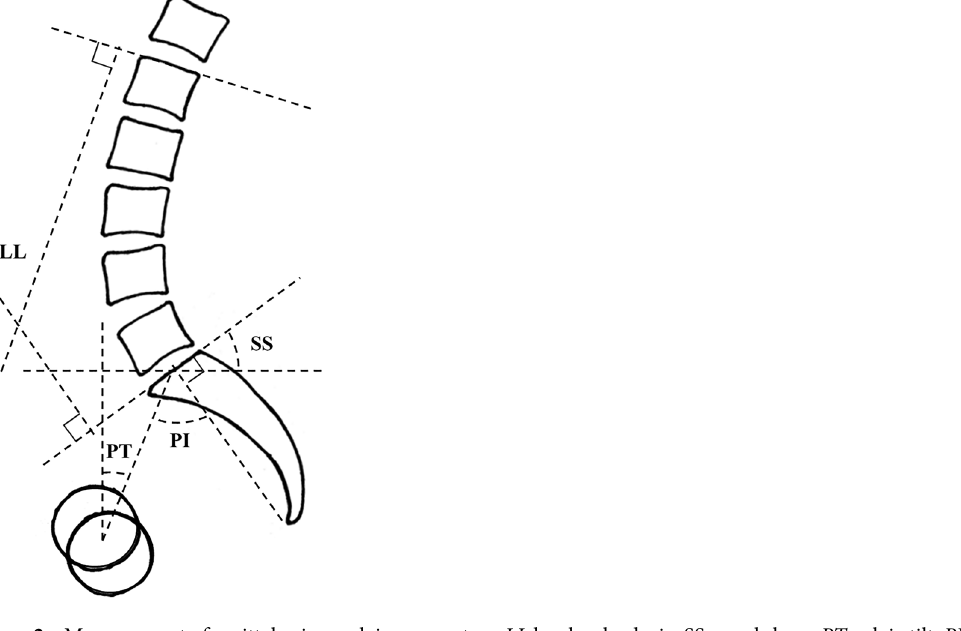
Figure 2. Measurement of sagittal spino-pelvic parameters. LL lumbar lordosis, SS sacral slope, PT pelvic tilt, PI pelvic